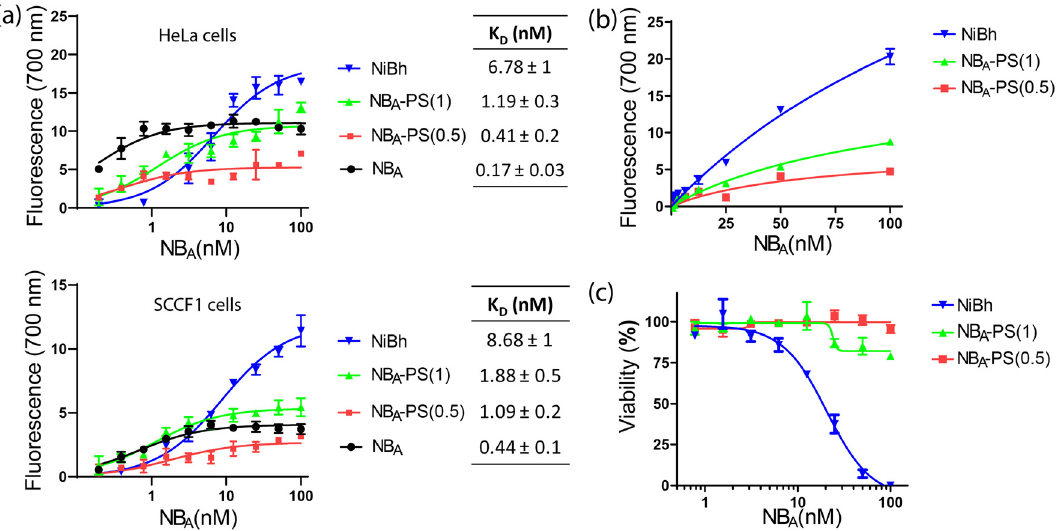
Figure 3: Binding affinity and potency of different NB A -PS conjugates. (a) A binding assay was performed with NB A, NB A -PS(0.5), NB A -PS(1), and NiBh using HeLa (top) and SCCF1 cells (bottom). The graphs display the saturation binding curves of each targeting molecule per cell line. Apparent binding af fi nity ( K D) values of each NB and conjugate are shown.(b)ToperformNB-PDT,aconcentrationrangeofNB A -PS(0.5),NB A -PS(1)orNiBhwasincubatedwithSCCF2cellsfor30minat37 ° C.The graph shows the PS signal on cells detected after washing off unbound conjugate, right before illumination. (c) The viability of the cells was assessed 24 h after illumination and expressed in percentage relative to nontreated cells.